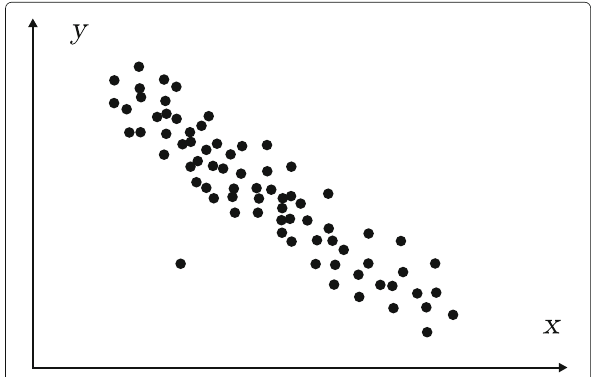
Fig. 6 Example of a two dimensional space with one outlying observation